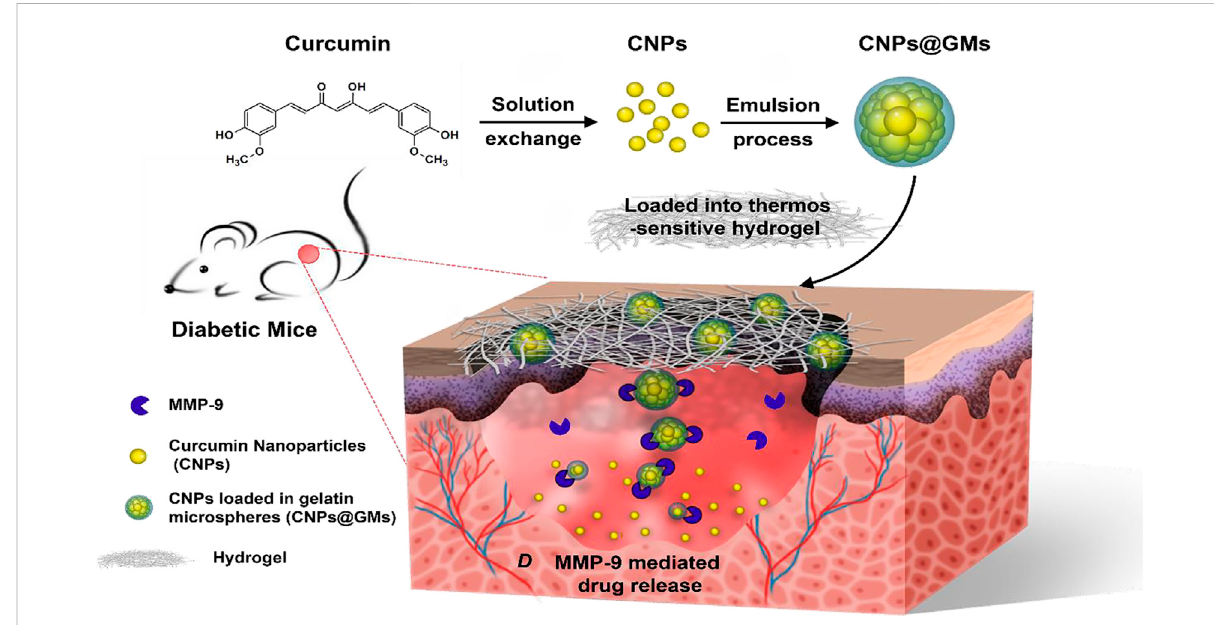
FIGURE 3 The preparation of curcumin nanoparticles/gelatin-microsphere hydrogel and the drug release process in the wound beds of diabetic mice. Reproduced from (Liu et al., 2018), with permission from American Chemical Society.